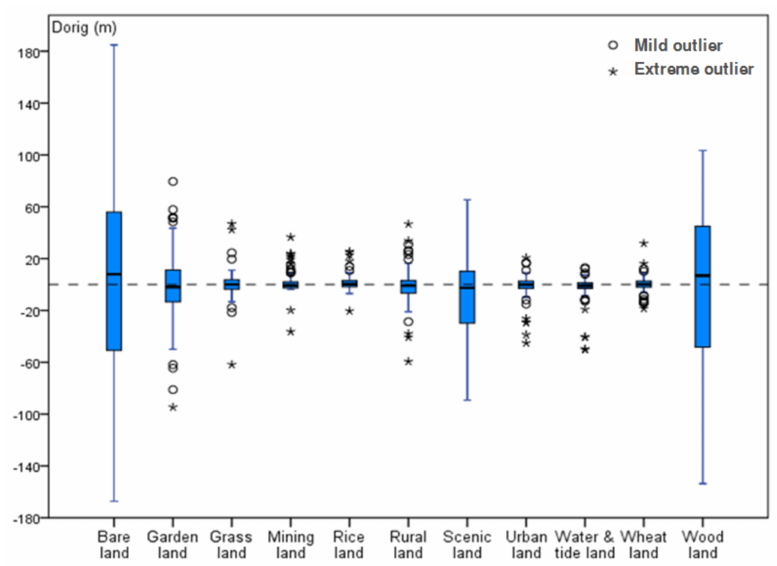
Figure 3. Boxplots illustrating the distribution of Dorig (the difference between the original GDEM2 and the first sample set).